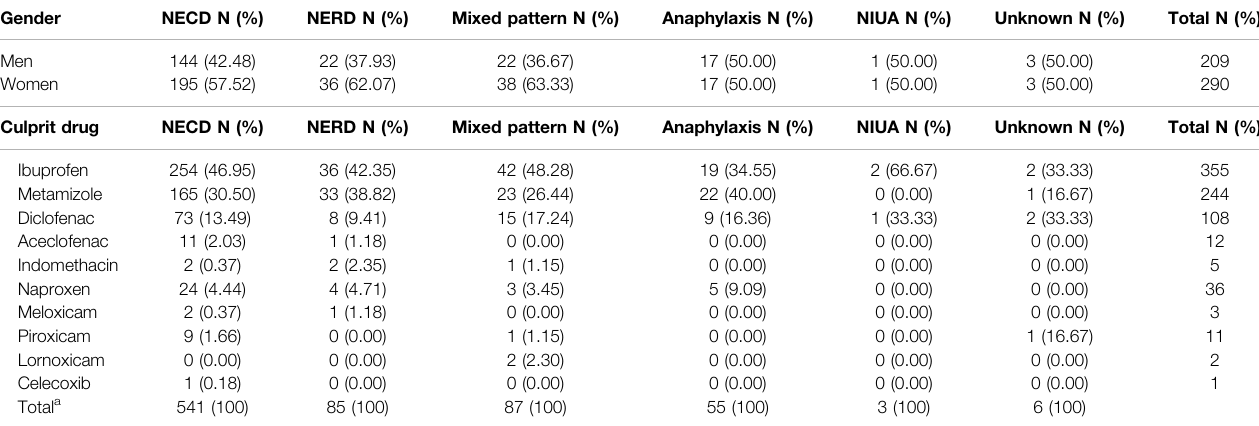
TABLE 2 | Gender and clinical presentation of NSAID-induced cross-hypersensitivity in this study.